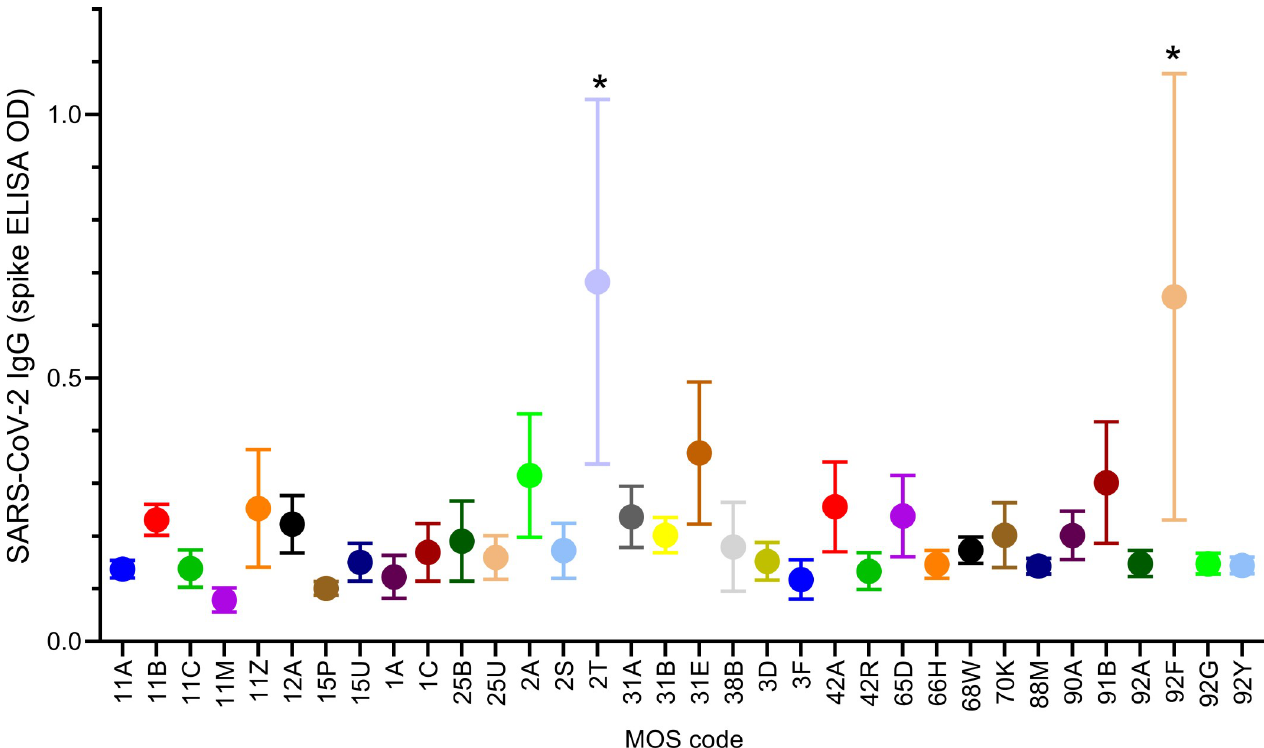
Fig 2. Spike antigen-specific IgG in serum from subjects with different MOS codes. The mean and standard error of spike IgG ELISA OD values are shown for subjects that belong to different MOS groups with N � 7 per MOS. � indicates significant ( p < 0.017) difference vs. other all other MOS codes.